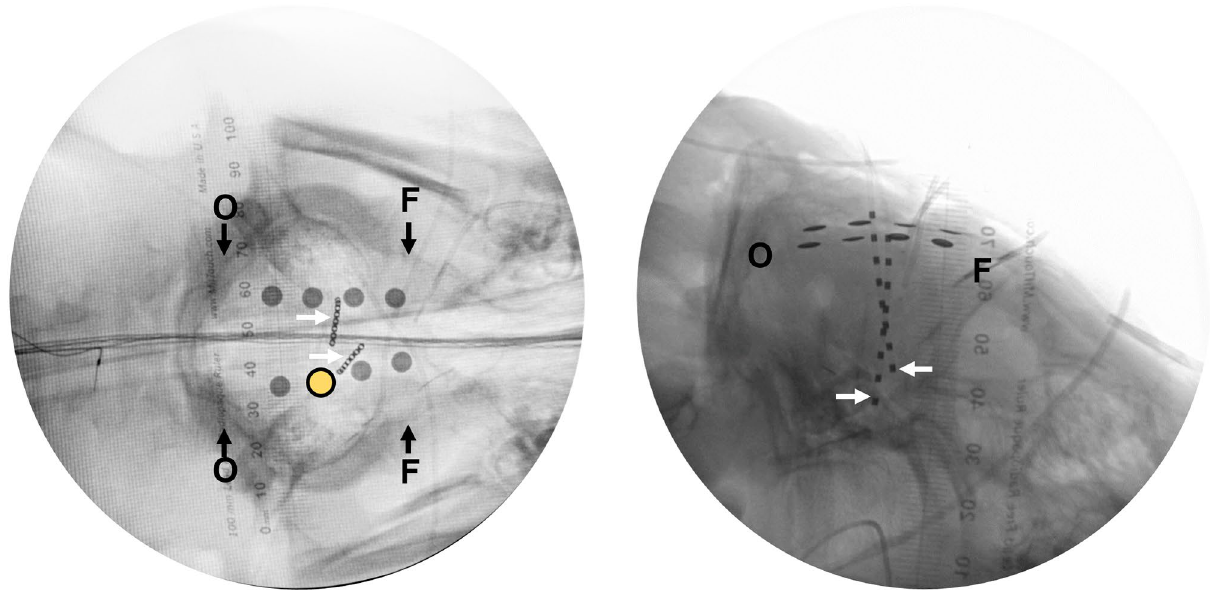
Figure 2. Pig electrode position. Selective views. Craniocaudal (i.e., vertical, left) and lateral (right) X-rays of 8 electrocorticography (in two strips) and 8 depth recording electrodes (in two linear depth electrodes) in place. Two linear, near vertical depth electrodes (8 recoding sites each) are marked with white arrows on each side of the midline. Eight circular pial electrocorticography electrodes are also shown. The highlighted electrode (yellow) was chosen for analysis of comparing activity with human data. Occipital (O) and frontal (F) areas are also marked for orientation. The ruler shown is divided in